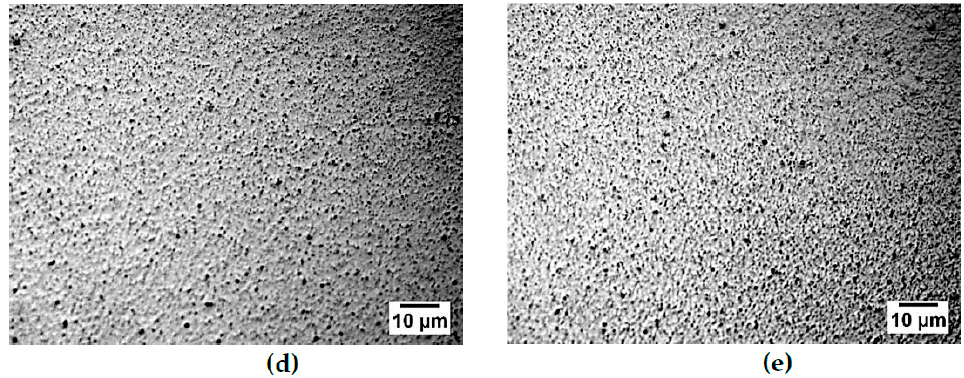
Figure 3. Reflected light microscopy image of ( a ) PU − PEG 10,000, ( b ) PU − PEG 8000, ( c ) PU − PEG 6000, ( d ) PU − PEG 4000, and ( e ) PU − PEG 2000.